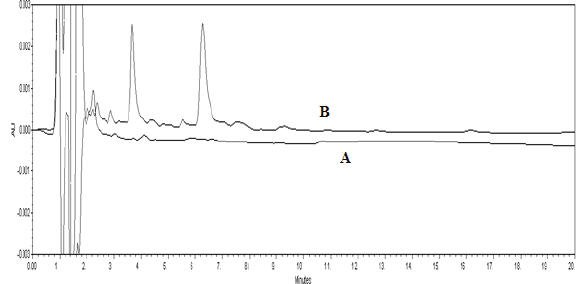
Table 3 : Analytical parameters of the investigated HPLC